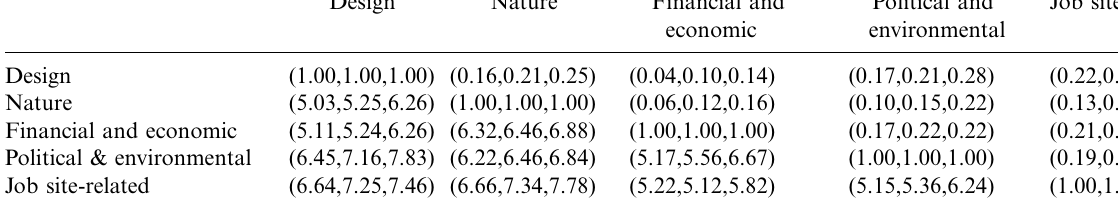
All the individual TFNs were aggregated into the group TFN. The aggregation score of each criterion was calculated using Eqs (3), (4), and (6). For instance, the aggregation score of ‘‘Cost and Time’’ under ‘‘Weather’’ was calculated as (3.18, 3.68, 4.18) as shown in Eq. (17). The aggregated scores for other criteria were obtained in the same way. Once the aggregation process was completed, the fuzzy compar- ison matrix of the criteria was produced as shown in